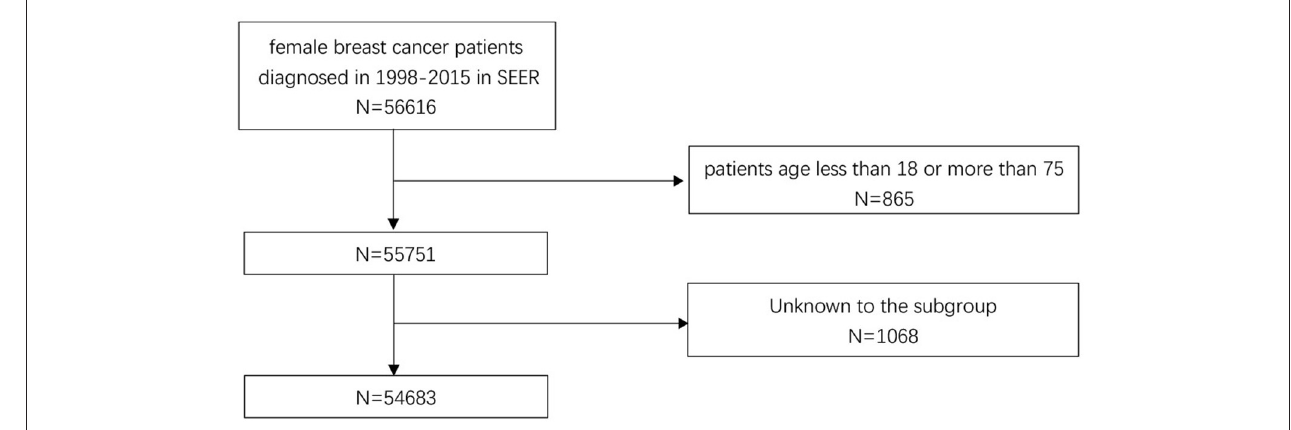
FIGURE 1 | Eligibility, inclusion, and exclusion criteria of the study population.